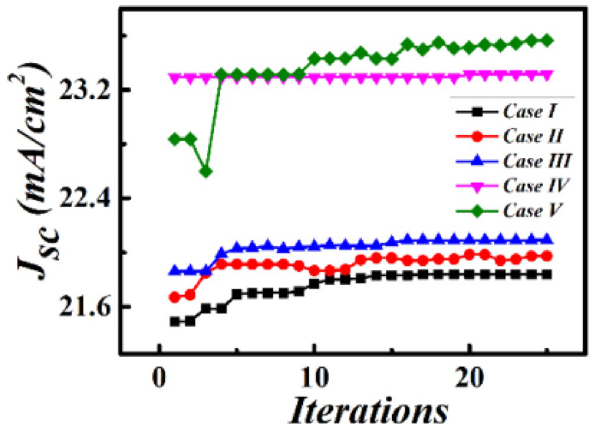
Figure 3. Simulated J sc versus simulation iteration times for the five proposed cases shown in Fig. 1.